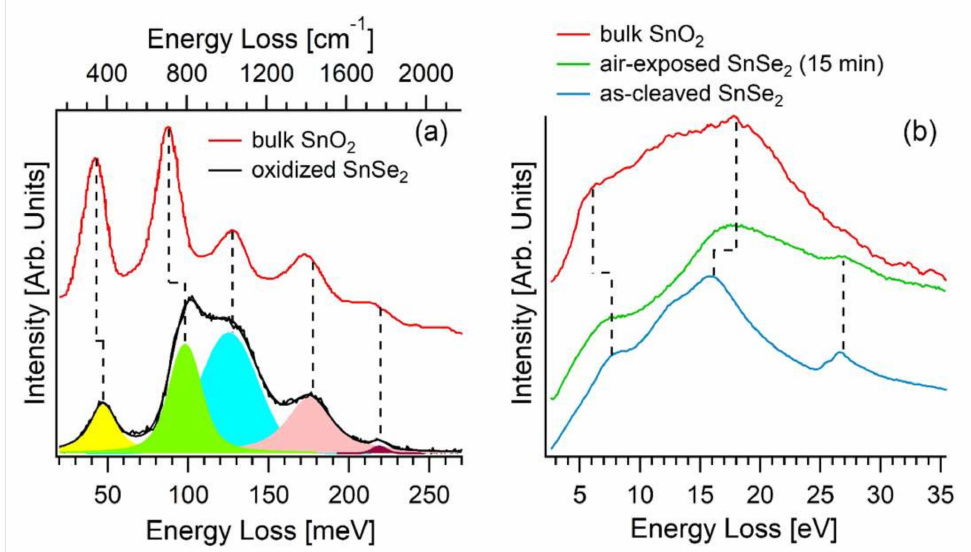
Figure 4. ( a ) Vibrational data for oxidized SnSe 2 (001) (recorded by HREELS with impinging energy of 4 eV) and bulk SnO 2 (110) (data taken from [56]). ( b ) Excitation spectrum for pristine and air-modified SnSe 2 (recorded by EELS with impinging energy of 300 eV) and bulk SnO 2 (data taken from